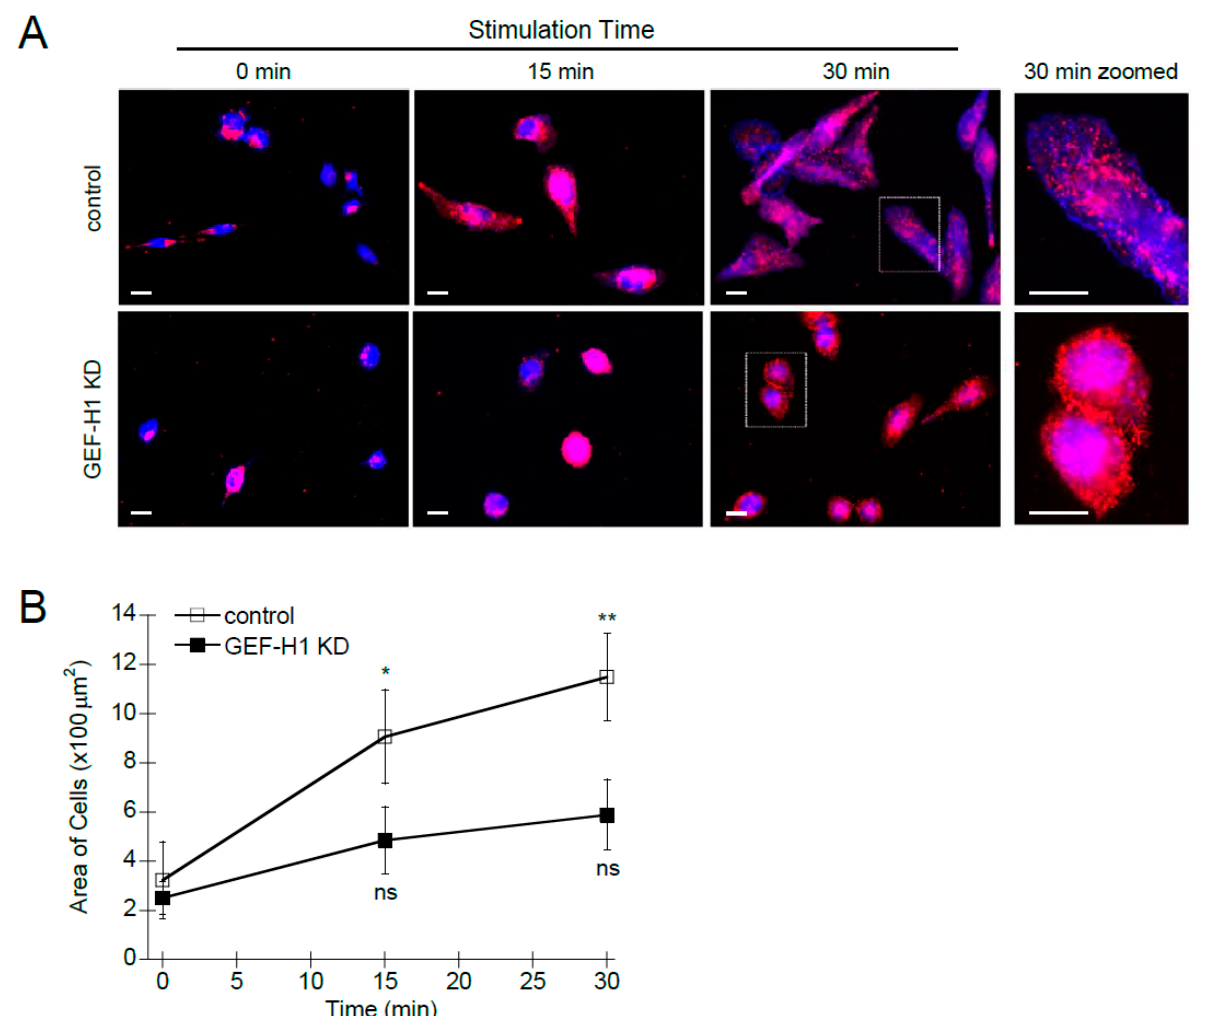
Figure 2. Depletion of GEF-H1 causes cell morphology defects. Control and GEF-H1 knockdown (GEF-H1 KD) RBL-2H3 cells were unstimulated (0 min) or antigen-stimulated for 15 min and 30 min. ( A ) Fixed cells were labeled with an anti-CD63 antibody (red) which labels granules [42], and Alexa Fluor 405-phalloidin which labels F-actin (blue). Scale bar = 20 µ m. ( B ) Quantification of cell size by ImageJ analysis. Knockdown of GEF-H1 significantly reduced cell spreading after 15 and 30 min of antigen stimulation. For statistical analysis, the size of 5 to 8 cells per condition (replicate measurements) was averaged from three independent experiments. Differences in cell size between stimulation time points were analyzed by Kruskal–Wallis tests ( p = 0.00858). Dunn’s post hoc tests were used to identify significant differences between the size of unstimulated and stimulated cells (* p = 0.0266 and ** p = 0.00591 for control cells stimulated 15 and 30 min, respectively; not significant (ns) for GEF-H1 KD